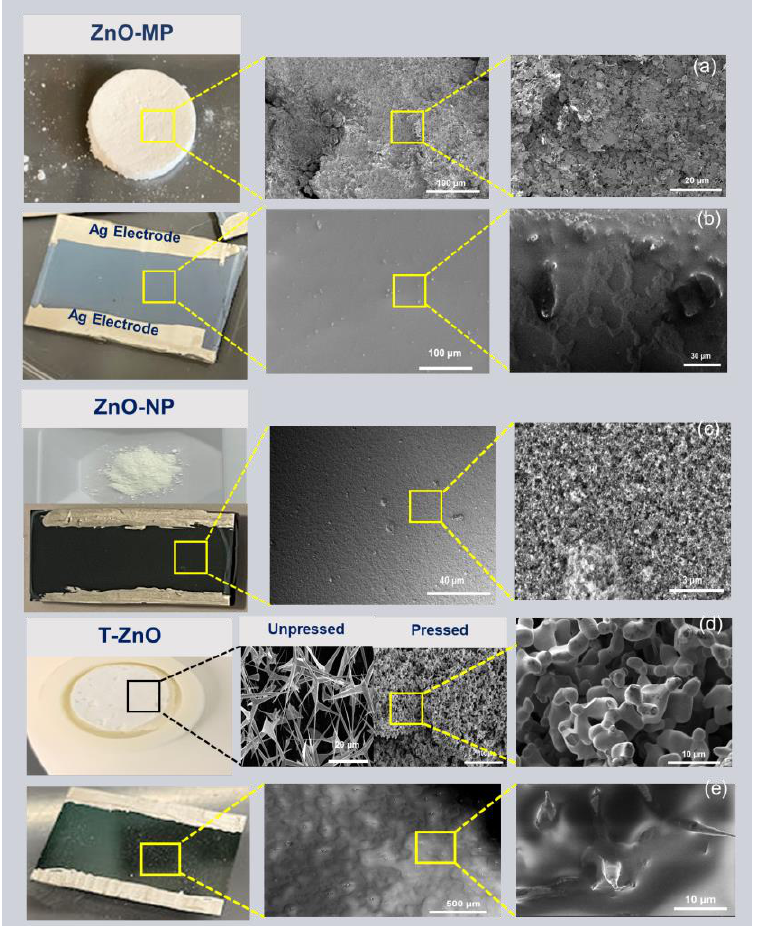
Figure 1. SEM images showing surface morphology. ( a ) ZnO-MP bulk pellet. ( b ) ZnO-MP thin film. ( c ) ZnO-NP powder and thin film. ( d ) T-ZnO pellet from the powder synthesized via direct flame transport method, unpressed and pressed forms showing networked tetrapod arms. ( e ) T-ZnO thin film. All of the thin films show colloidal silver (Ag) paste electrodes.